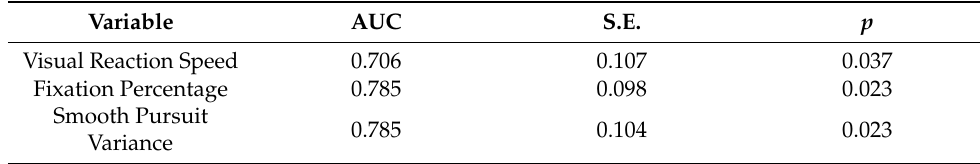
Table 5. Summarization of outcomes for the ROC curve analysis.